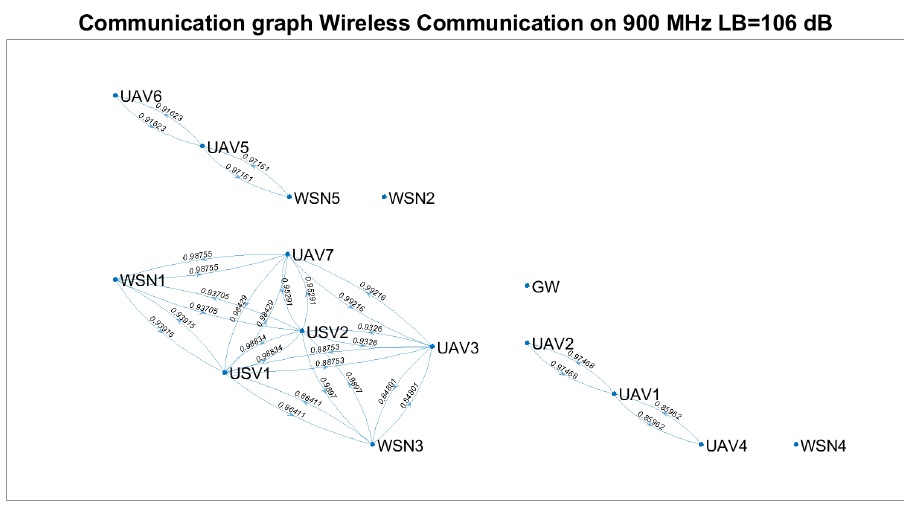
Figure 15. Corresponding initial communication graph. Scenario depicted in Table 14, ρ = 0.2.